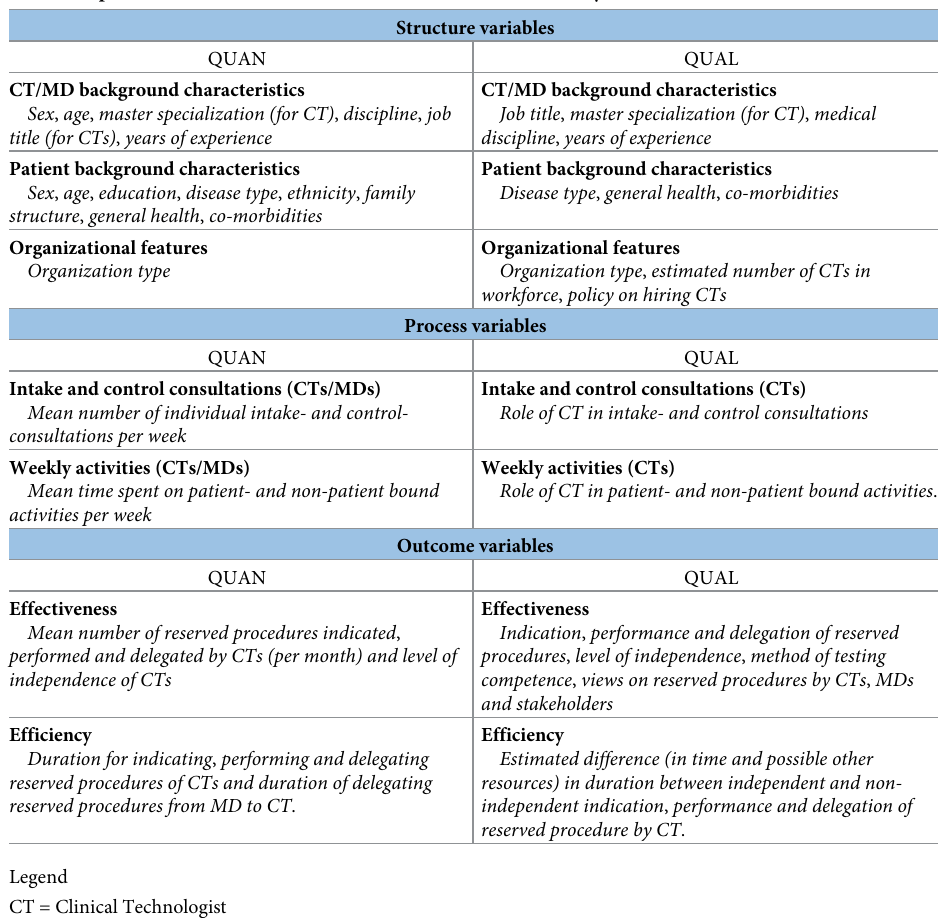
Table 1. Operationalization of Sidani & Irvine framework for this